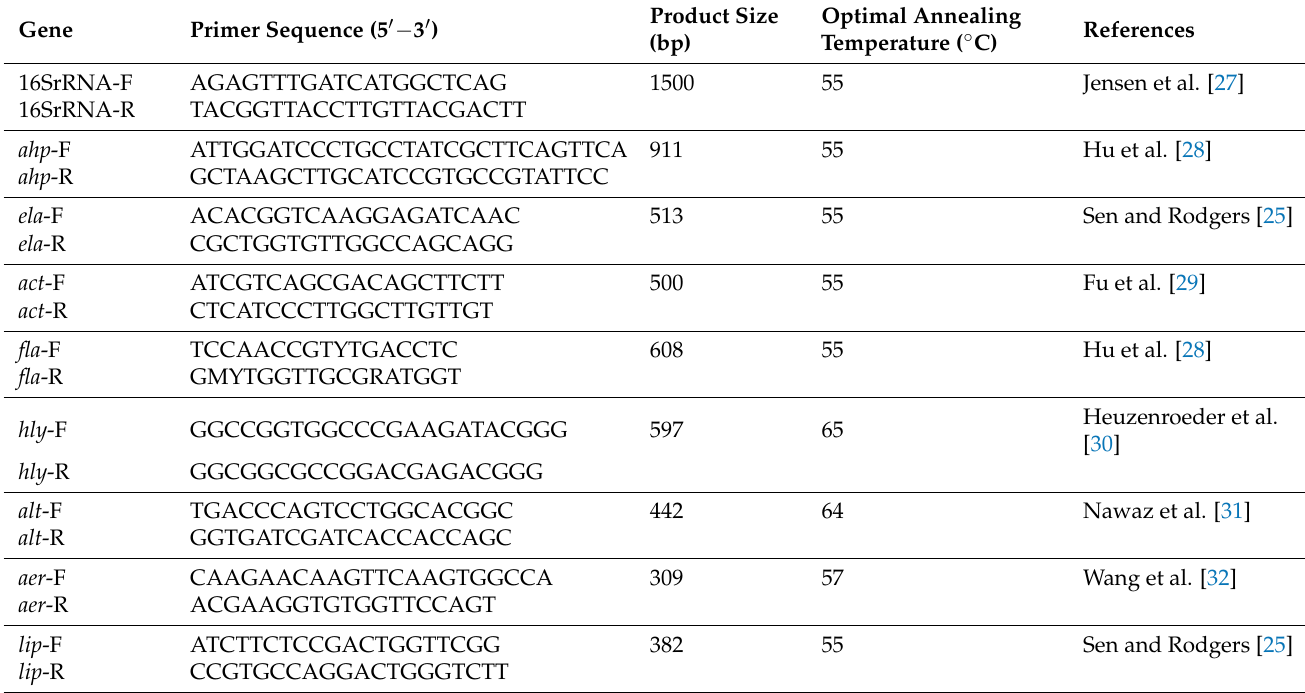
Table 1. Primers for 16S rRNA and virulence gene